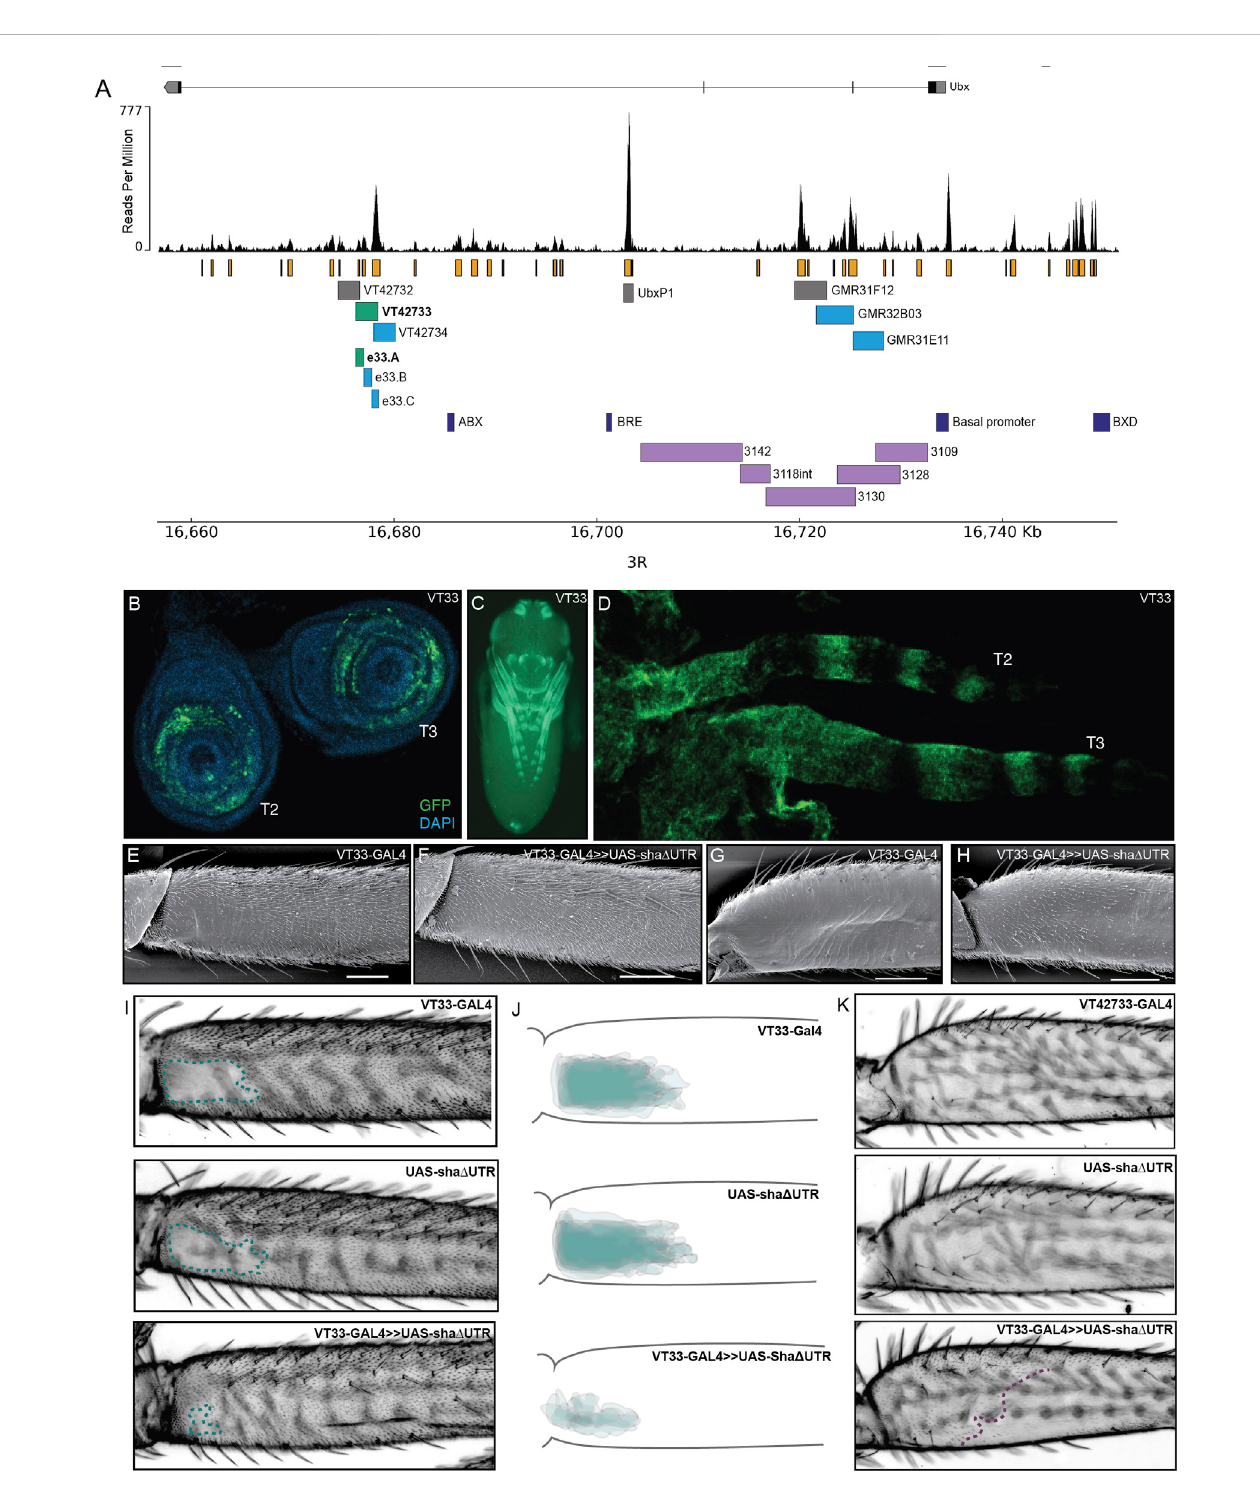
FIGURE 2 Testing regions of accessible chromatin at the Ubx locus for enhancer activity. (A) The Ubx locus in Drosophila melanogaster on chromosome arm 3R withtheATAC-seqpro fi lefor Ubx inpupal legsbelow.Inorangearepeaksofopenchromatin andunderneatharethelocations oftestedorknownregulatory elements. In green are the lines tested in this study that affect trichome patterning on T2 and T3 legs. In blue are the lines which express GFP in pupal legs but do not have a functional effect on trichome patterning. In grey are the lines which do not drive expression in pupal legs. In dark blue are a subset of the characterised regulatory elements of Ubx . For a complete list of all characterised elements according to RedFly see Supplementary Material S2. In purple are the reporter constructs that were tested by Davis et al. (2007) that did not contain the leg speci fi c enhancer of Ubx . (B) UAS-GFP expression driven by VT42733-GAL4 (referred to as VT33-GAL4) in T2 and T3 leg imaginal discs from 3rd instar larvae is seen in the femur ring of the disc but also other leg segments. (C) ExpressiondrivenbyVT33-GAL4inwholepupaeat24hAPF.Expressionispresentinseveraldifferenttissuesincludingthepupallegs,antennae, mouthparts,eyes,andgenitalia. (D) InT2andT3pupallegsfrom fl iesat24hAPF,theexpressiondrivenbyVT33-GAL4isobservedinthedevelopingfemurand also in a striped pattern more distally in the pupal leg. (E) Scanning electron micrograph (SEM) showing the NV of a wild-type T2 proximal femur. (F) SEM of